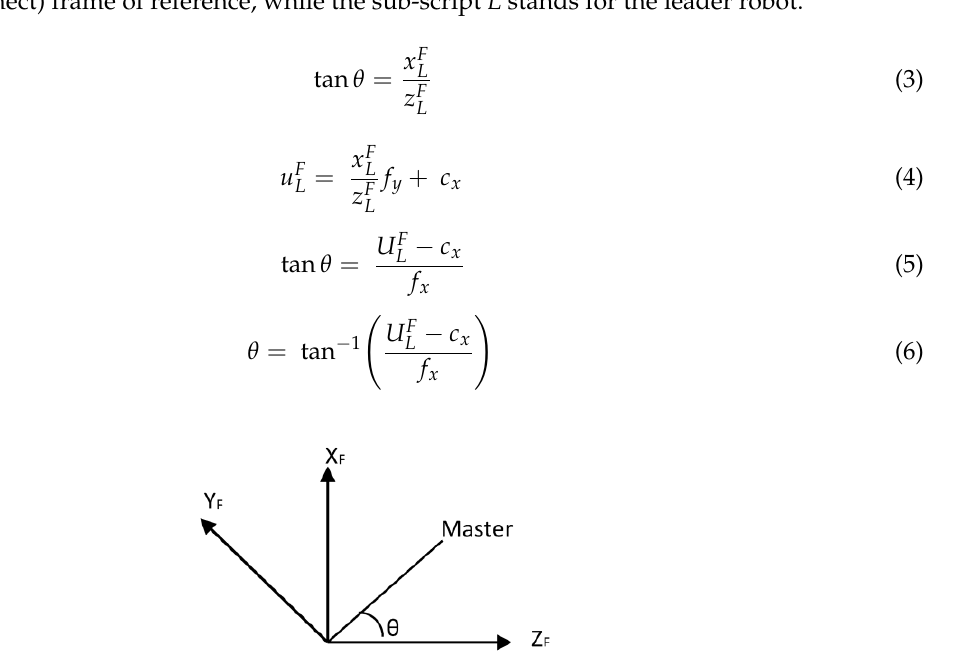
( b ) Figure 3. ( a ) Tele-operation of the master robot; ( b ) The master robot. 2.2. Vision The vision module is a part of the follower robot and is responsible for recognizing and locating the master robot. The master robot is assumed to be of a single color, not otherwise present in the environment. This is achieved by wrapping the master robot with colored paper. A color detection filter is used, which is a median filter whose ranges are calibrated prior to the start of the experimentation. The master robot is recognized as the single largest block, with a size greater than a